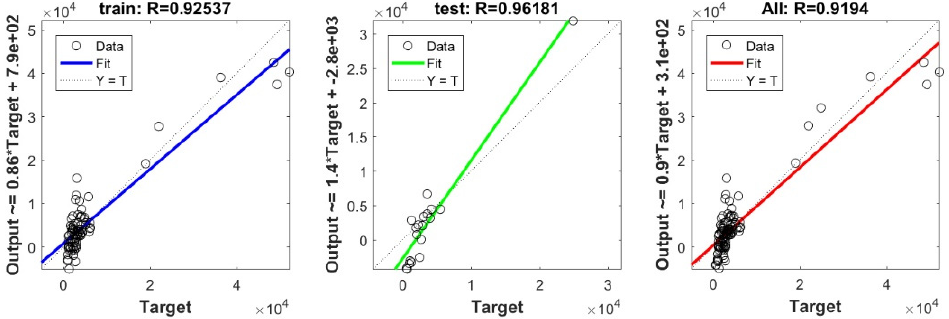
Figure A7. Scatter plots between target and output values by the PLS model.